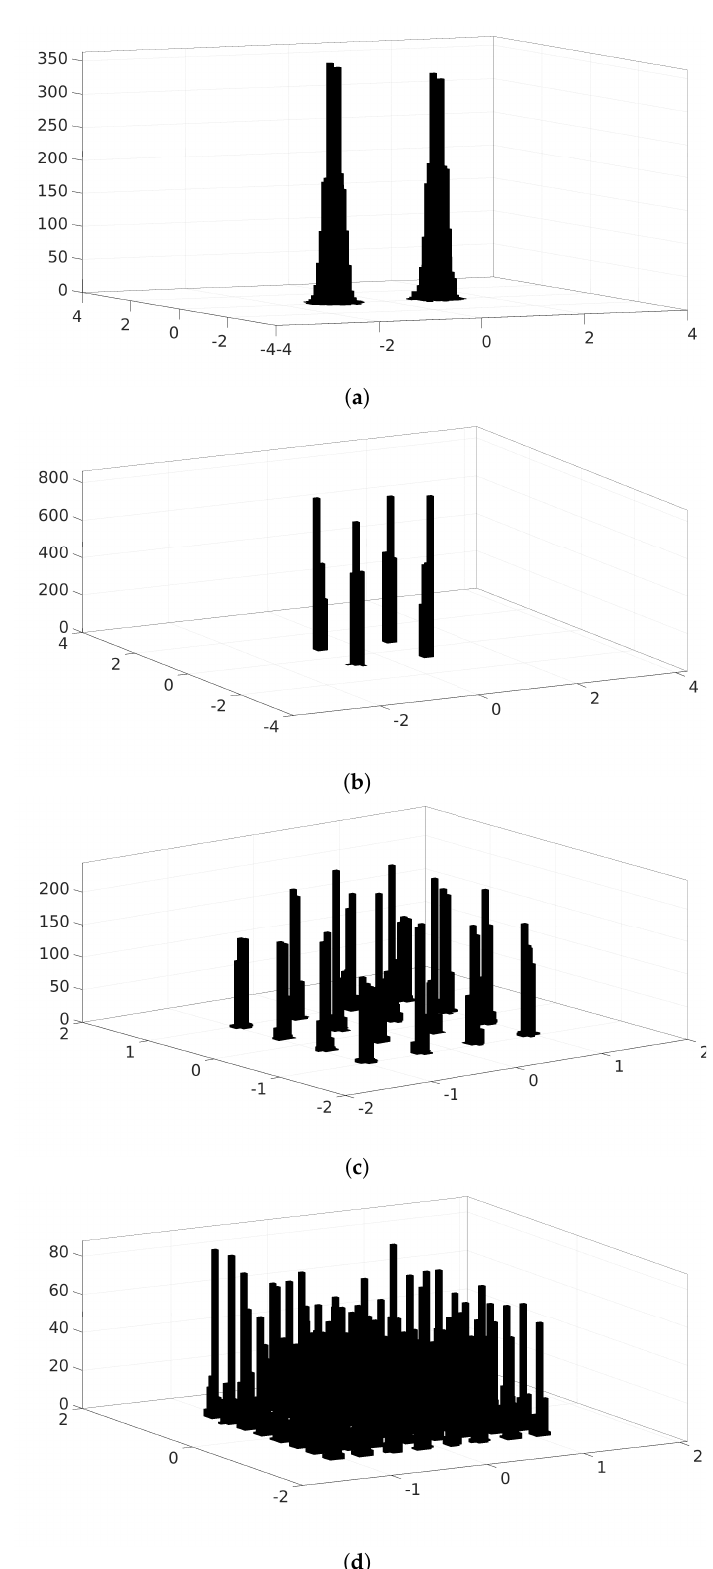
Figure 2. Histogram representation of various modulation schemes. Both the x and y axes are divided into 80 levels over the intervals x , y ∈ [ − 4,4 ] . ( a ) BPSK scheme histogram representation; ( b ) QPSK scheme histogram representation; ( c ) 16-QAM scheme histogram representation; and ( d ) 64-QAM scheme histogram